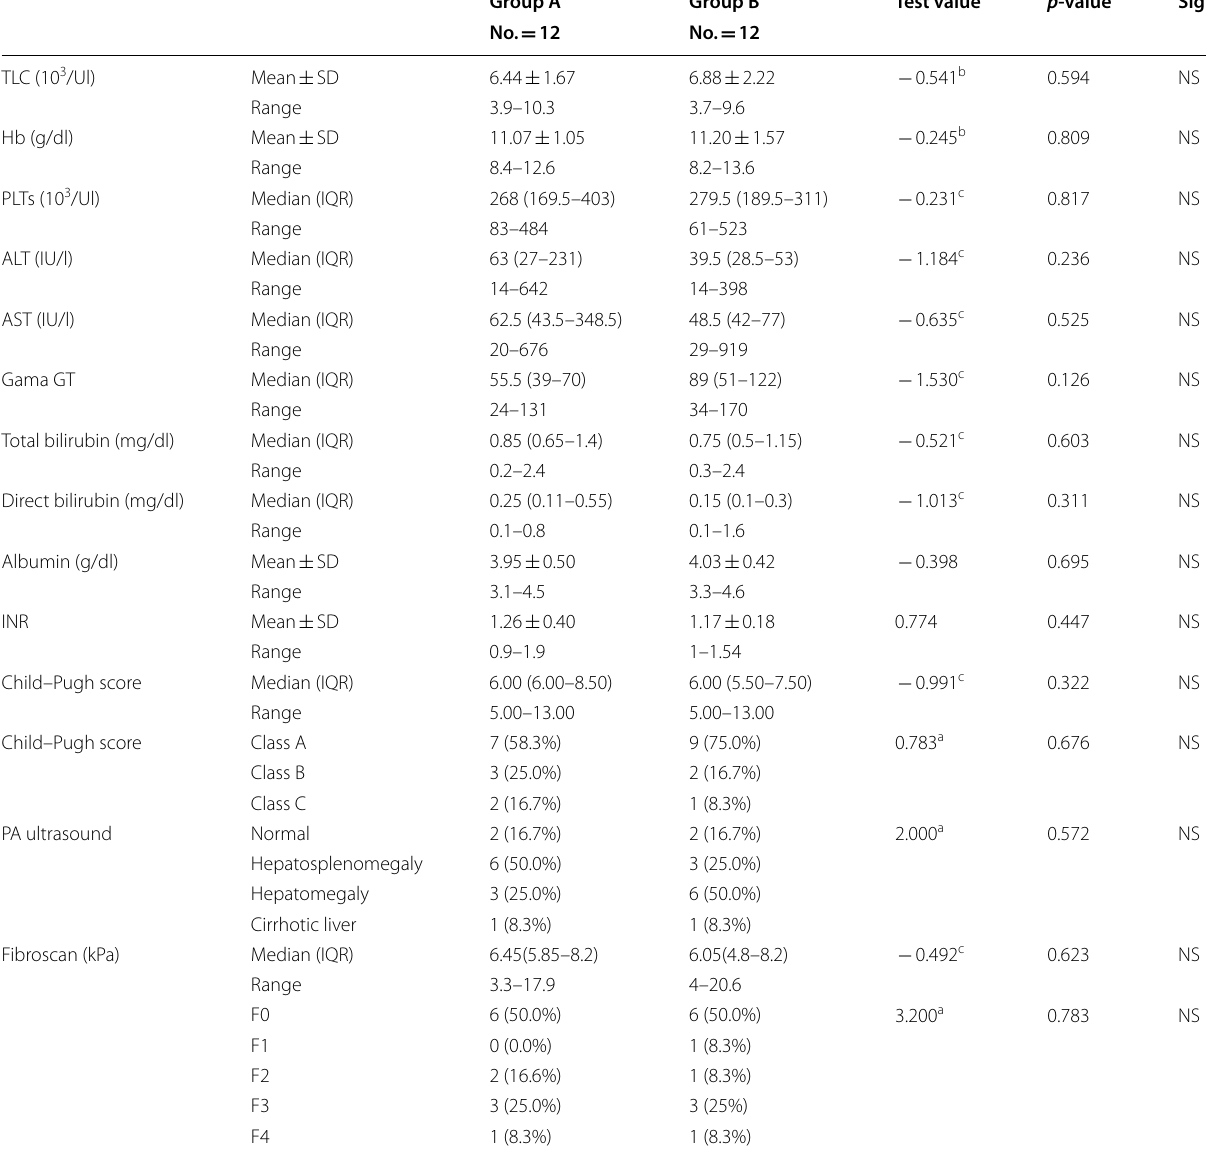
Table 5 Comparison between group A and group B regarding laboratory and radiological findings before vitamin D